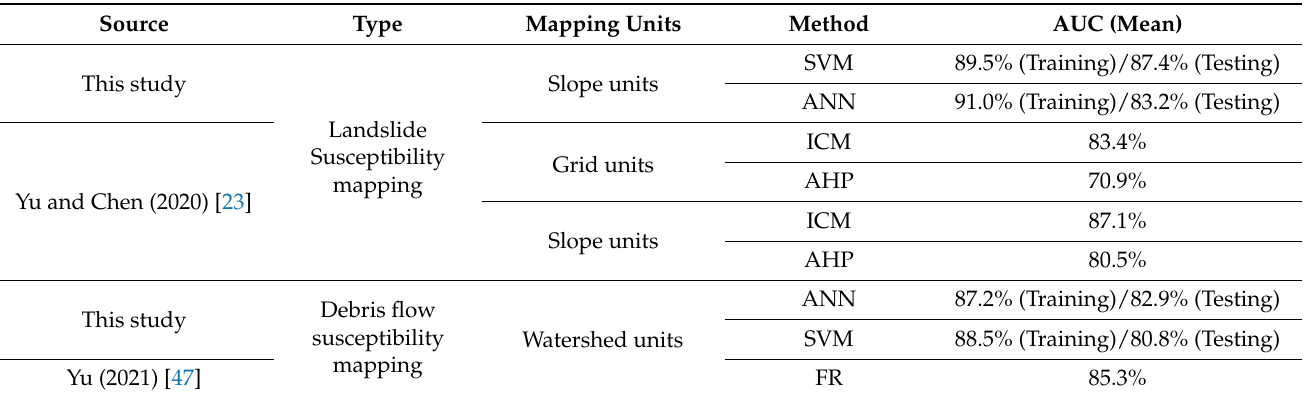
Table 5. Model fitting results of the study